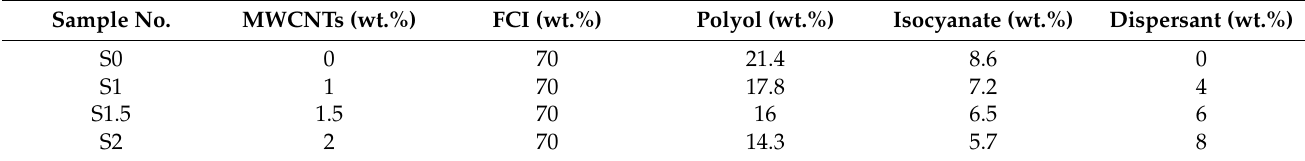
Table 3. Material